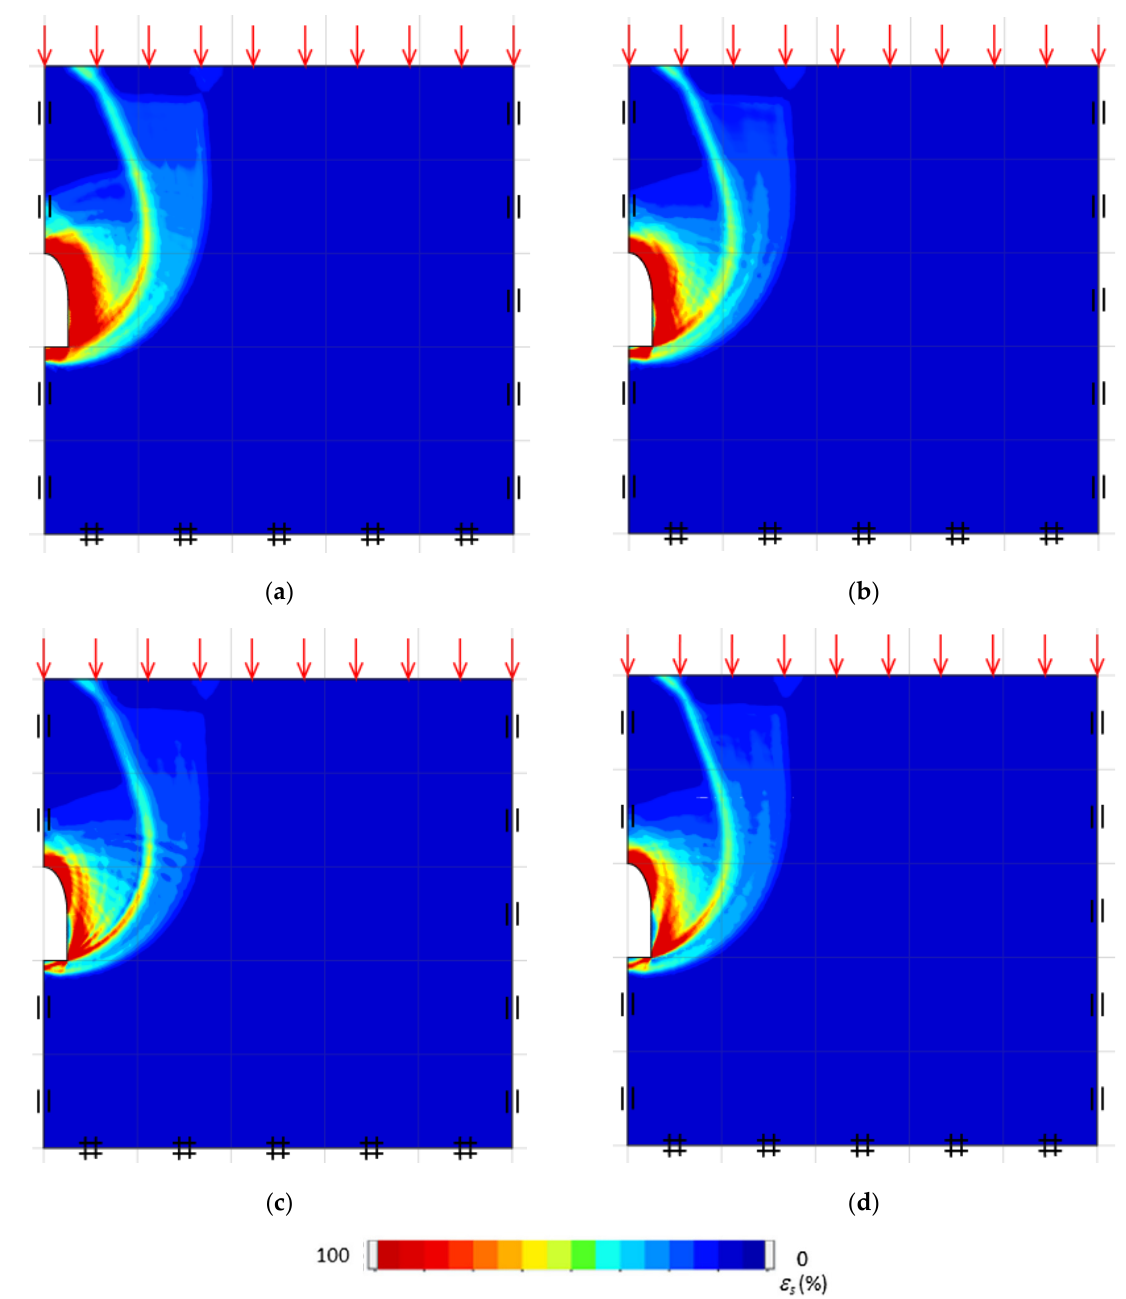
Figure 11. Shear dissipations for various GSI : ( a ) 40, ( b ) 60, ( c ) 80 and ( d ) 100 ( C / D = 2, B / D = 0.5, σ ci / γ D = 1000 and m i = 20).